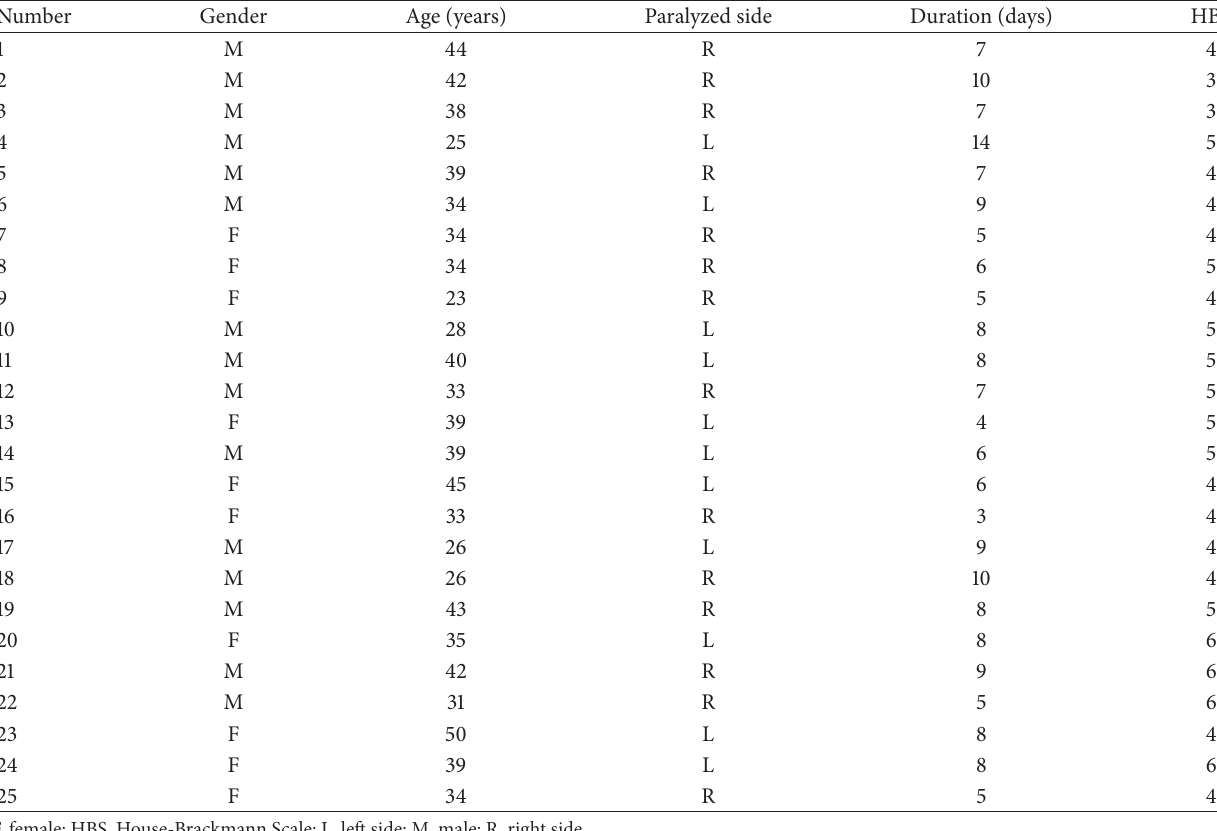
Table 1: Clinical data for all BP patients.